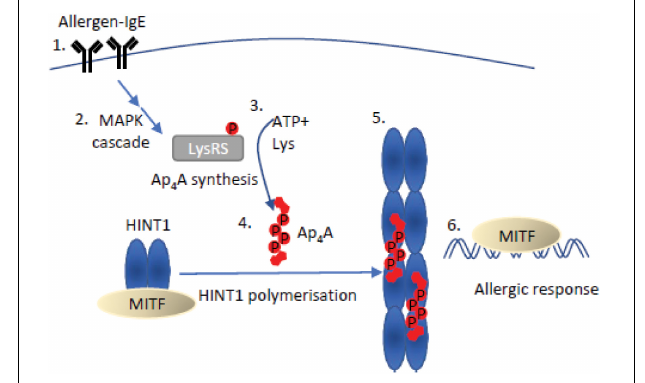
FIGURE 3 | Mechanism of Ap 4 A mediated regulation of HINT1-MITF. An allergen bound to IgE (1) stimulates the mitogen-activated protein kinase (MAPK) cascade (2) , resulting in the phosphorylation of LysRS on serine 207. Phosphorylation of LysRS increases Ap 4 A synthesis 3-fold (3) (Yannay-Cohen et al., 2009). The increase in Ap 4 A concentration causes dissociation of the MITF-HINT1 complex as Ap 4 A and MITF compete for the same binding site on HINT1. Ap 4 A binding to HINT1 promotes its polymerization (5) . Ap 4 A bridges the HINT1 dimer–dimer interface promoting association with the adjacent dimer facilitating their polymerization (Yu et al., 2019). Following HINT1 polymer formation, MITF translocates to the nucleus to promote transcription of target genes and initiate an allergic response (6) (Yu et al.,